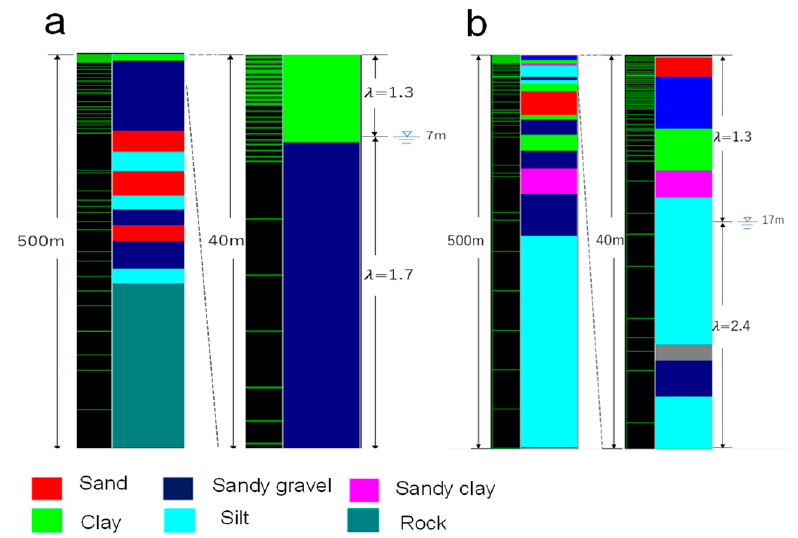
Figure 6. Mesh design of the heat transfer simulation for ( a ) Sapporo and ( b ) Tokyo.